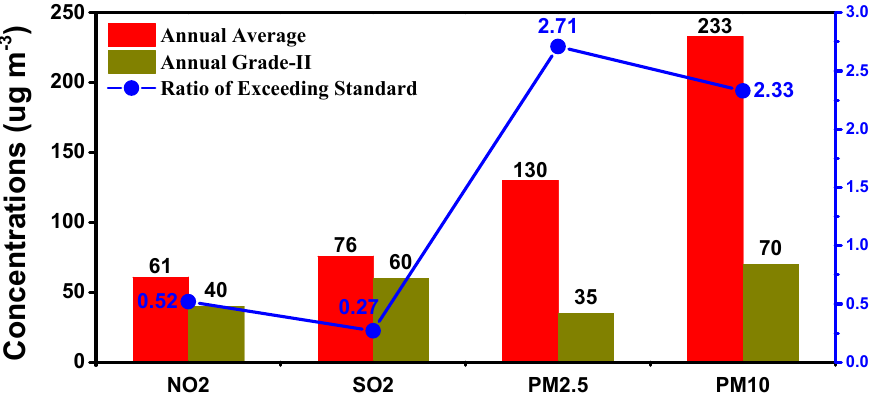
Figure 2. Annually average value of NO 2 , SO 2 , PM 2.5 and PM 10 and the ratio by which they exceeded Chinese NAAQS guidelines (2014, on-line data).